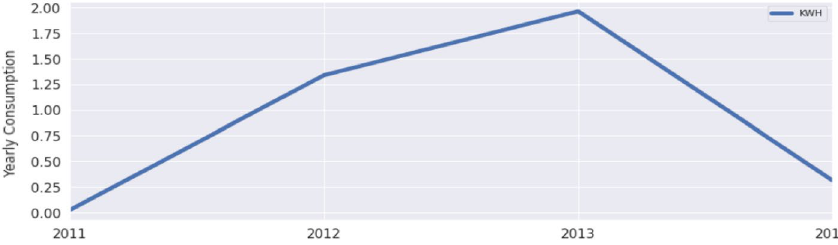
Fig. 11 Diagram of average yearly